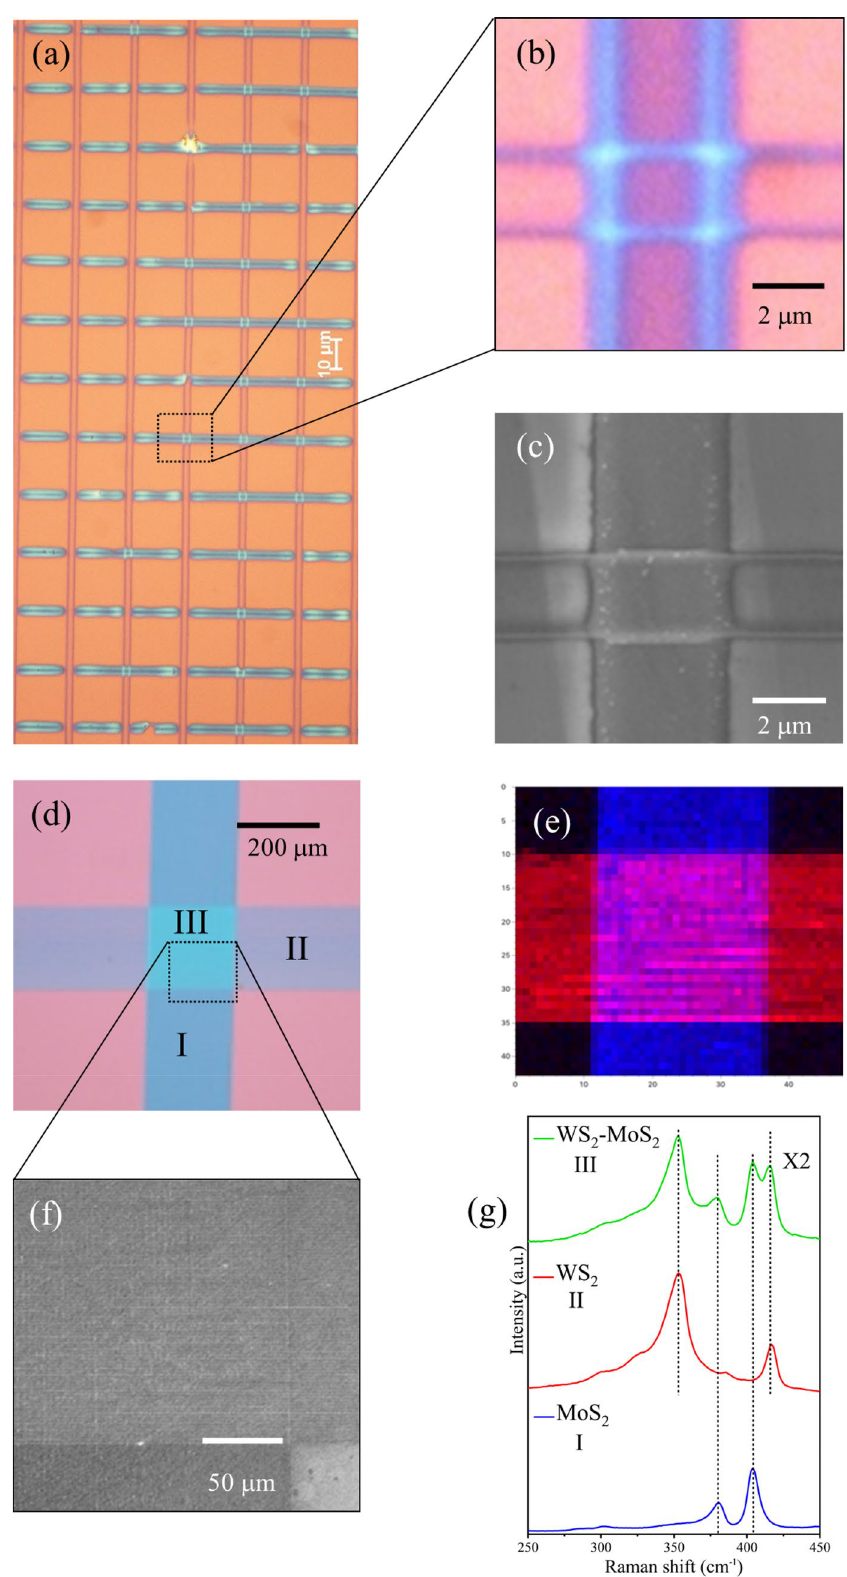
Figure 4. ( a ) Optical microscopy image of a WS 2 /MoS 2 heterostructure array. ( b , c ) Optical microscopy image and Scanning Electron microscopy (SEM) of a single WS 2 /MoS 2 heterostructure. ( d ) Optical microscopy image of an array of multiple overlapping WS 2 /MoS 2 tracks forming a large area heterostructure. ( e ) False colour X-Ray fluorescence map of the large area WS 2 /MoS 2 heterostructure shown in ( d ), where the red and blue bands correspond to X-Ray fluorescence from Mo and W atoms respectively. ( f ) Scanning Electron microscopy (SEM) of ( d ) showing crosshatch pattern. ( g ) Raman analysis of ( d ) is strongly indicative of a sharp vertical interface with the characteristic modes of both materials (I = MoS 2 , II = WS 2 ) present in region